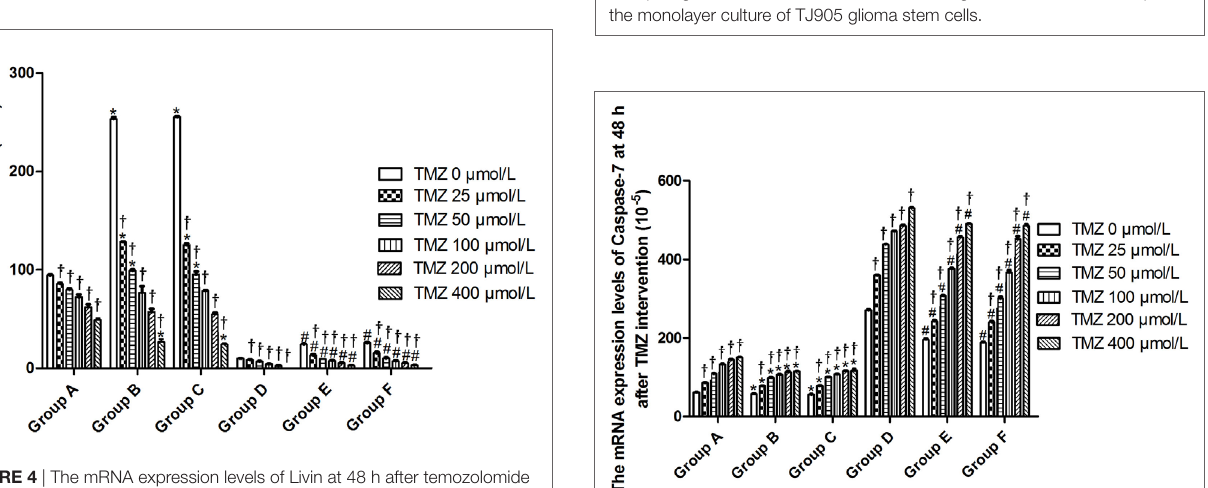
FigUre 5 | The mRNA expression levels of Caspase-3 at 48 h after temozolomide (TMZ) intervention (10 − 5 ). * P < 0.05, compared with Group A in the same concentration; † P < 0.05 compared with the concentration of 0 µmol/L; # P < 0.05 compared with Group D in the same concentration. Group A: TJ905 cells transfected with Livin-shRNA, Group B: TJ905 cells transfected with negative-shRNA, Group C: the monolayer culture of TJ905 glioma cells, Group D: glioma stem cells transfected with Livin-shRNA, Group E: glioma stem cells transfected with negative-shRNA, and Group F: the monolayer culture of TJ905 glioma stem cells.